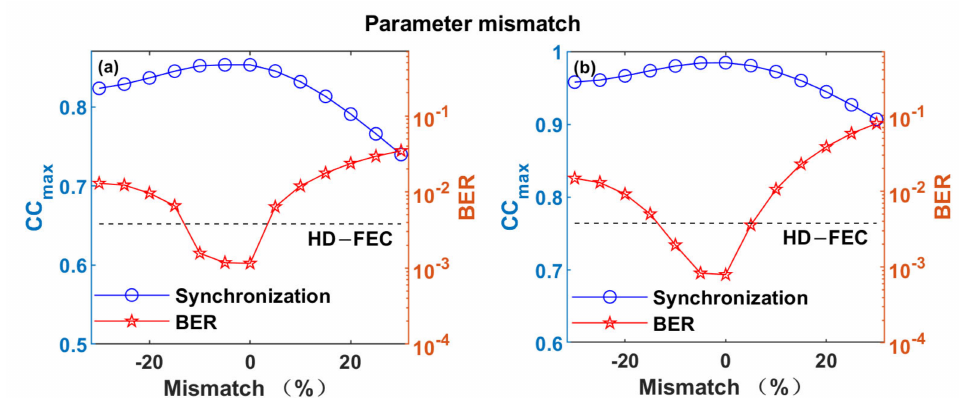
Figure 8. Parameter mismatch investigation for ( a ) Message 1 after 120 km transmission and ( b ) Message 2 after 20 km